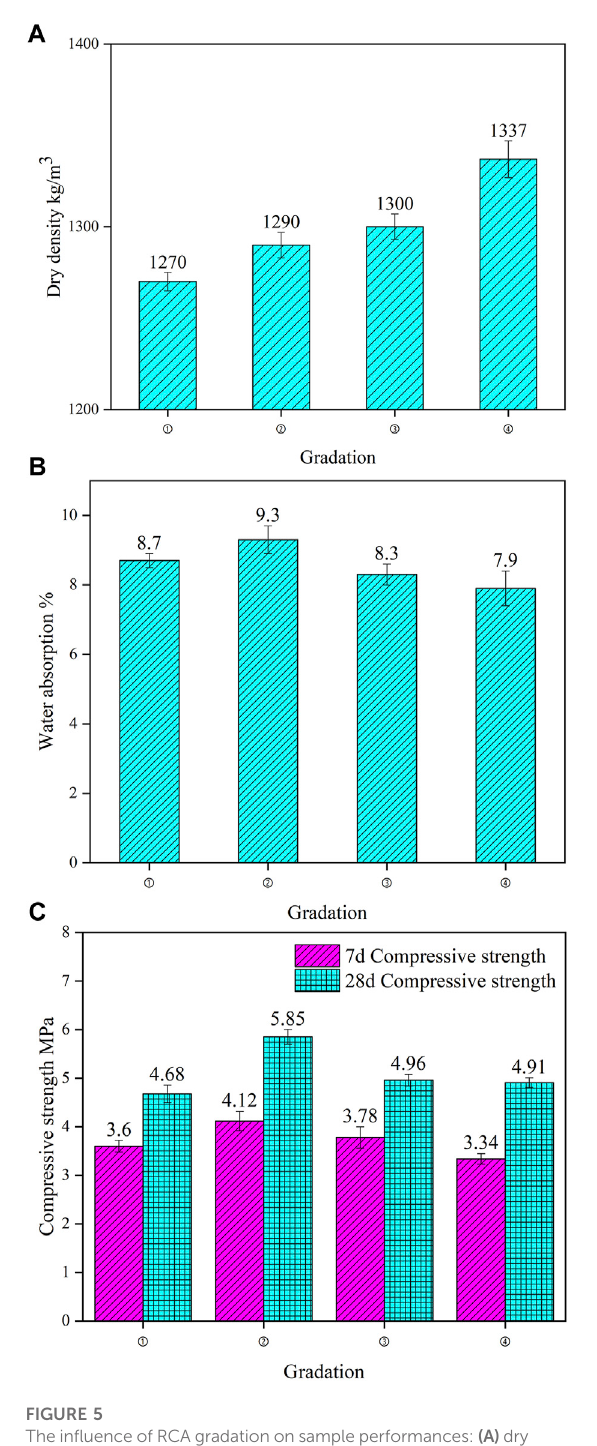
FIGURE 5 The in fl uence of RCA gradation on sample performances: (A) dry density; (B) water absorption; (C) compressive